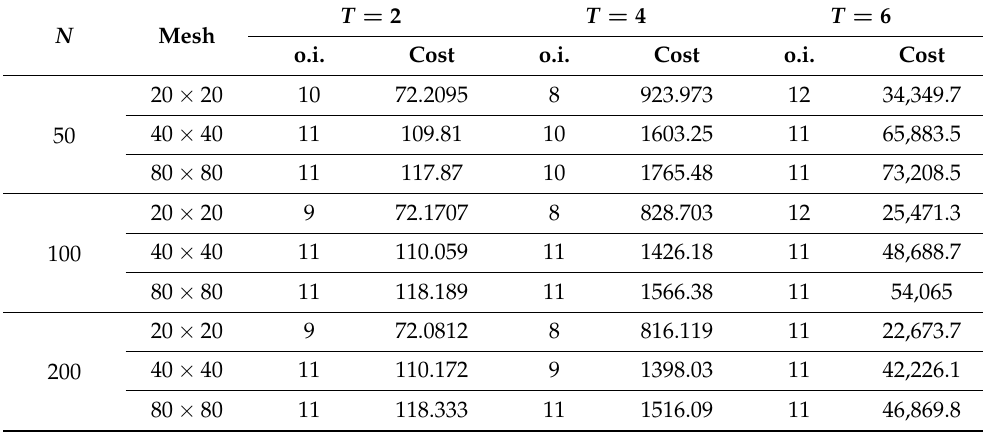
Figure 3. Uncontrolled state u ( a , c , e ) and Trajectory γ and controlled state u ( b , d , f ) at different times T with a minimal and a maximal value detailed in Table 2. Table 3. Number of outer iterations (o.i.) and cost for each final time T , time subintervals N and